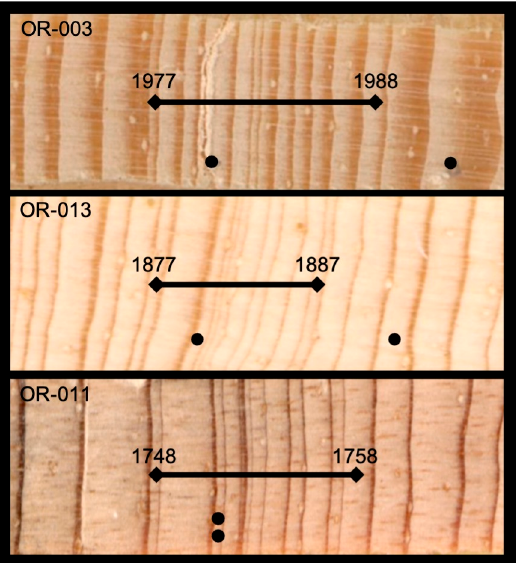
Figure 4. Examples of pandora moth suppressions from Orderville Canyon. Each black line is a defoliation event specific to the individual sample. The year 1879 is locally absent in the OR-013 sample.